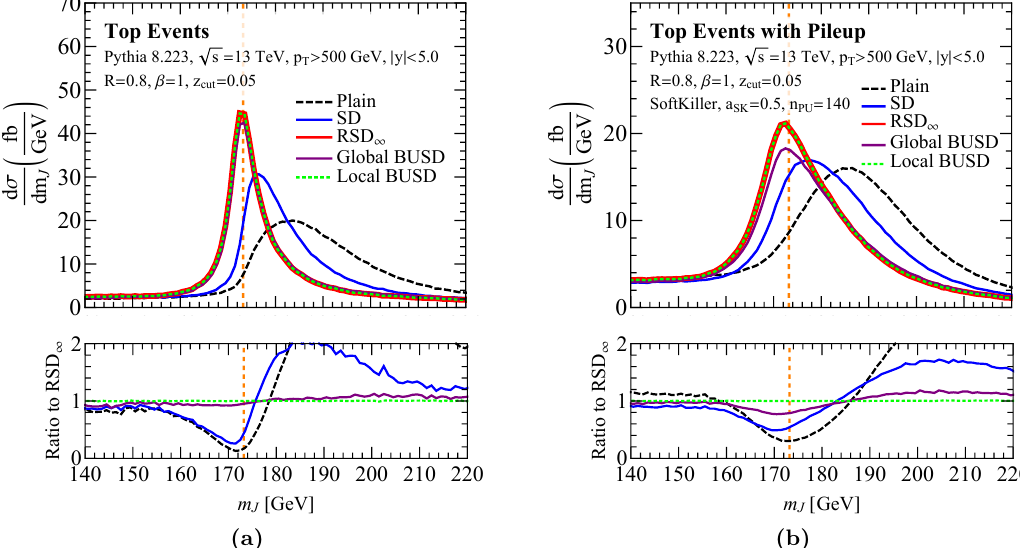
Figure 13. Behavior of global and local BUSD on t (cid:22) t events with the default RSD parameters. (a) Performance without pileup, to be compared to (cid:12)gure 7a. (b) Performance with 140 pileup vertices plus SoftKiller, to be compared to (cid:12)gure 11a. In both panels, the ratios to RSD 1 are shown at the